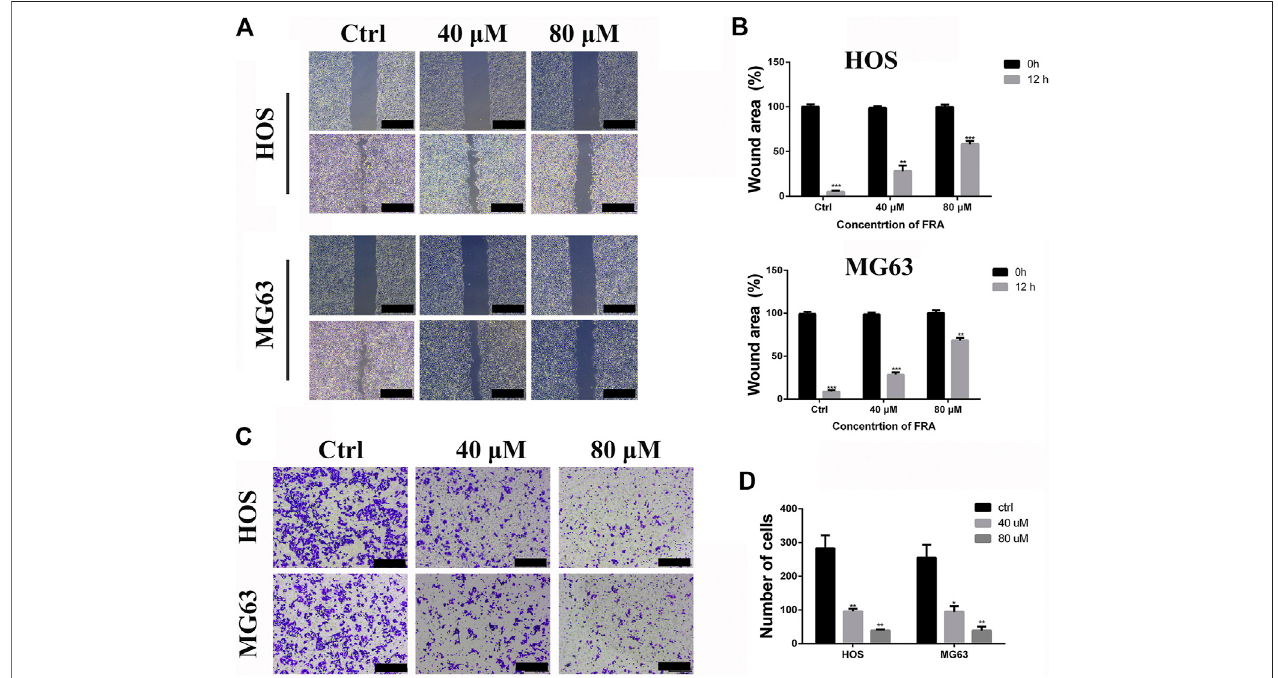
FIGURE2| FRAinhibitsosteosarcomacellmigration invitro . (A) TheHOSandMG63osteosarcomacelllineswereincubatedwithvariousdosesofFRA(0;40 μ M; 80 μ M)for12 h,andphotographs takenat0and 12 hwerestatisticallyanalyzed byImageJsoftware.Theresultsofwound-healingassayshowedthatFRAsigni fi cantly blocked the cell recolonization in the wound area in the HOS and MG63 cell lines. (C) In the transwellassay under the same conditions, the number of cells in of the FRA treatment group was signi fi cantly lower than that of the control group, and the number of cells in the high dose was less than that in the low dose. Percentages of wound area (B) and number of clones (D) in the lower membrane were counted. Error bar (cid:2) mean ± SEM of at least triplicate experiments. Magni fi cation, × 40 (A) , × 100 (C) . Scale bar, 500 μ m (A) , 200 μ m (C) . * p < 0.05, ** p < 0.01, *** p < 0.001, # p <